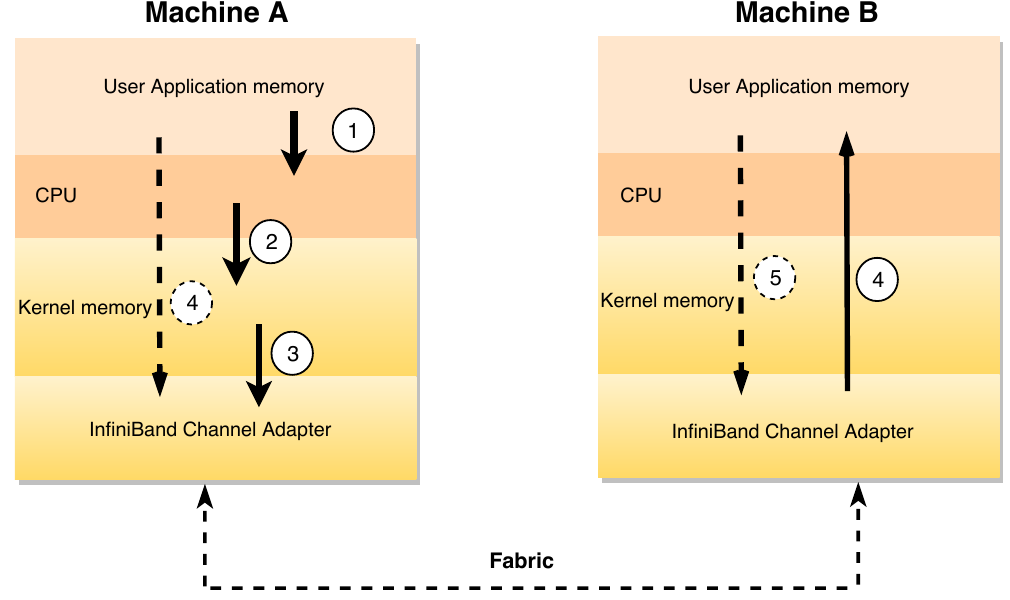
Figure 2. RDMA communication cutting